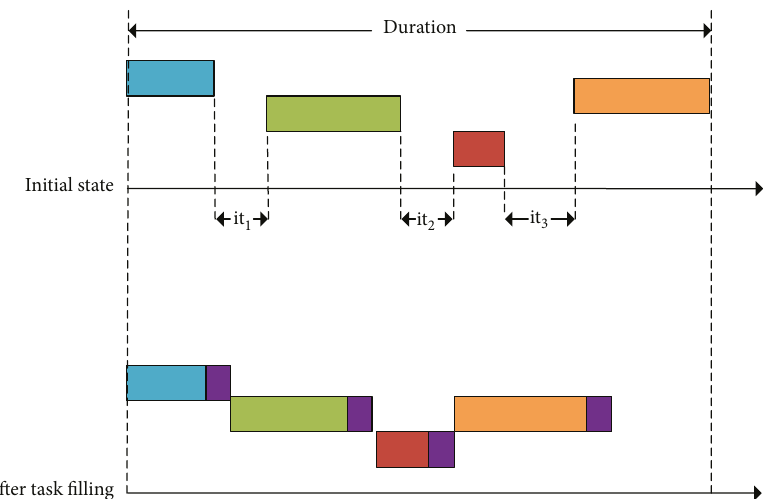
Figure 3: Task fi lling of